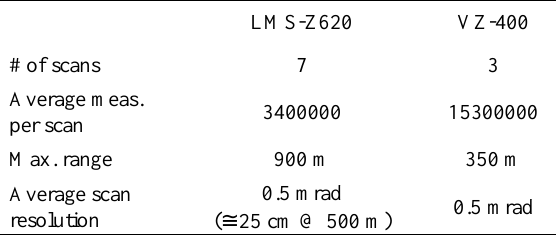
Table 3: Some properties of acquired laser